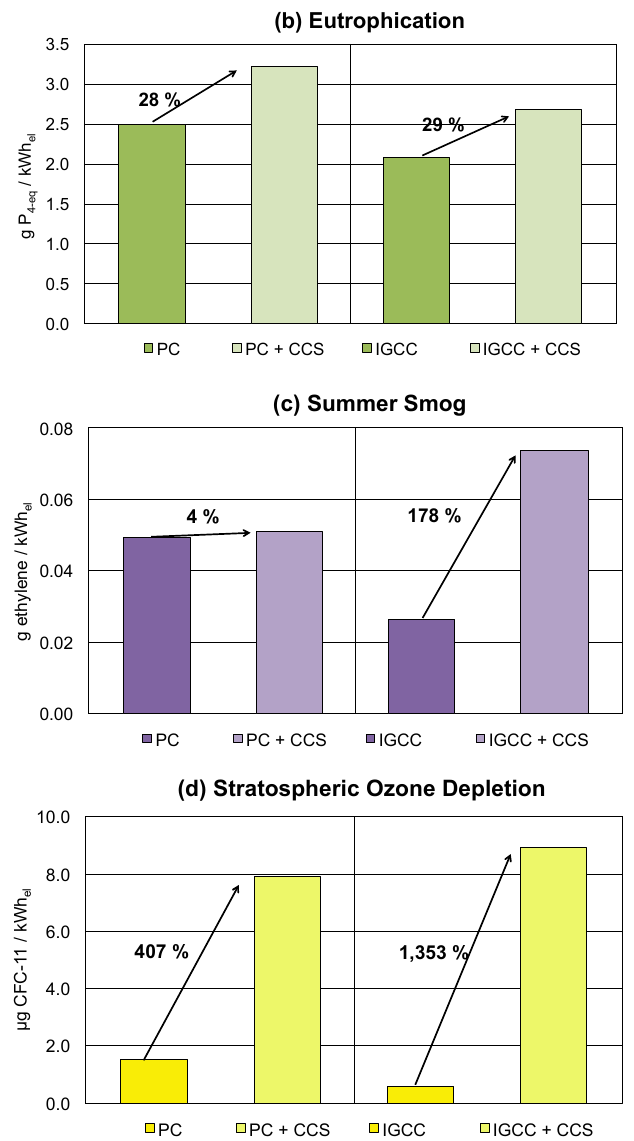
Figure 9. Results of selected non-GHG impact categories for PC and IGCC power plants with and without CCS in South Africa in 2030 from a life cycle perspective ( a ) Acidification; ( b ) Eutrophication; ( c ) Summer smog; ( d ) Stratospheric ozone depletion.